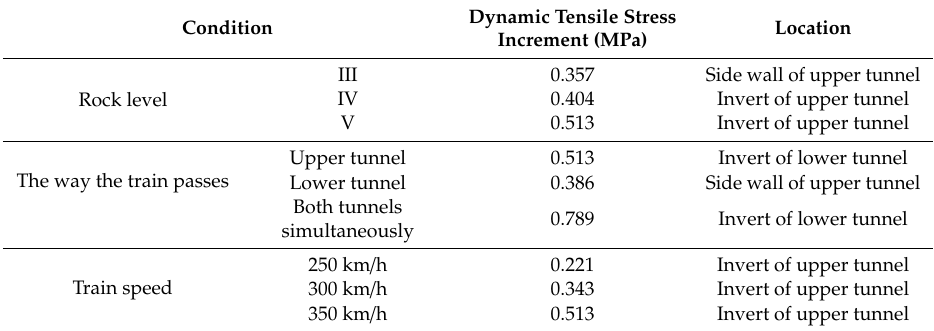
Table 7. Maximum dynamic tensile stress increment for di ff erent design parameters of the cross tunnel.